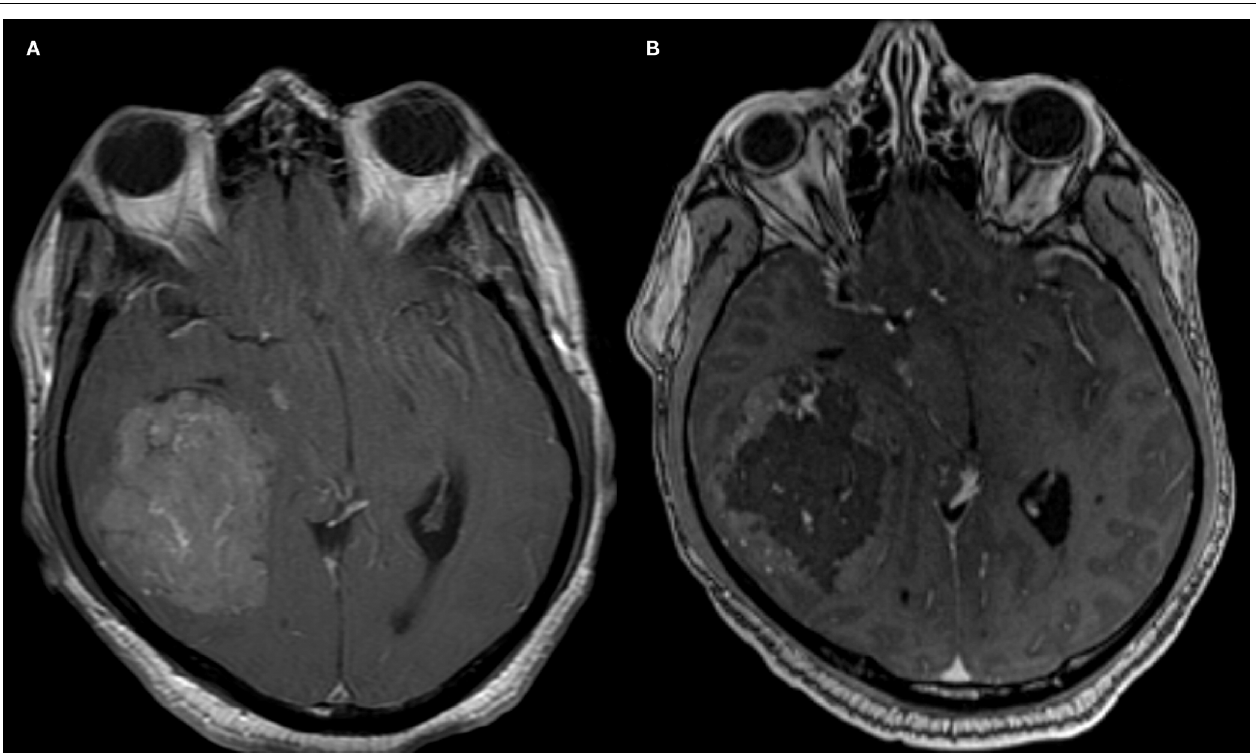
FIGURE 3 | Contrast enhanced MRI images of a middle cranial fossa meningioma obtained before (A) and after (B) endovascular tumor embolization with PVA particles demonstrate devascularization.